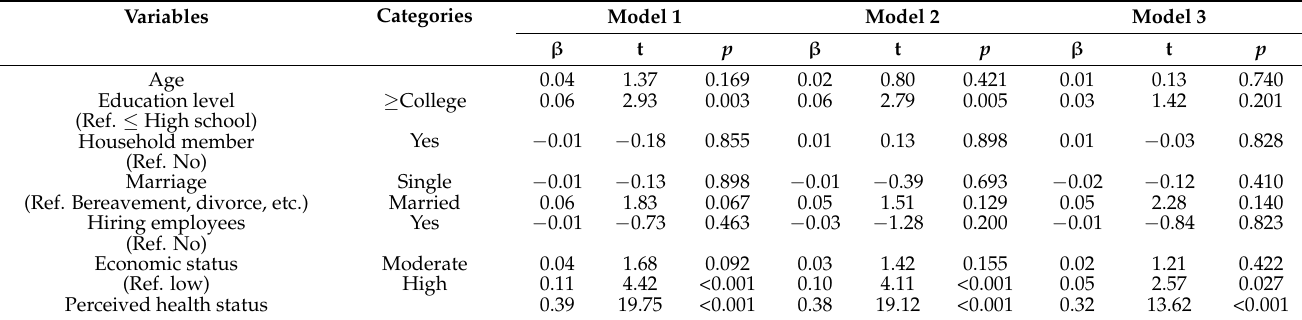
Table 2. Hierarchical multiple regression analysis predicting happiness ( N =